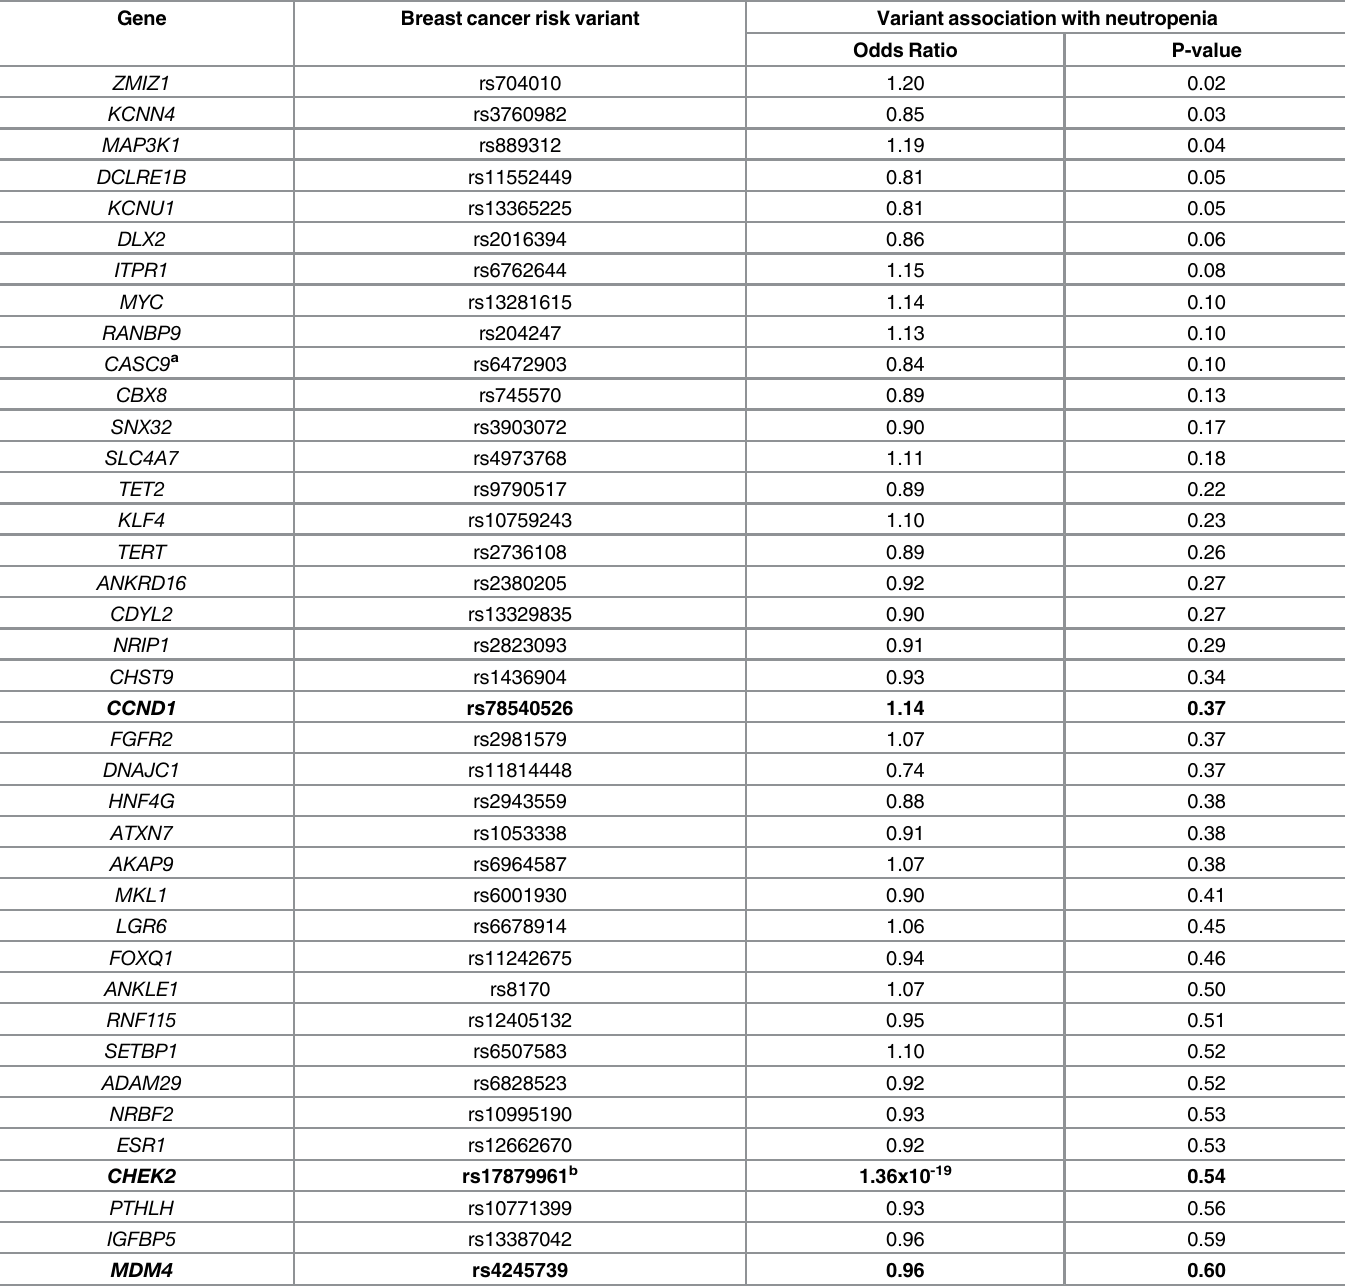
Table 4. Top 38 genes according to p-value for association between highest-ranking breast cancer risk variant and